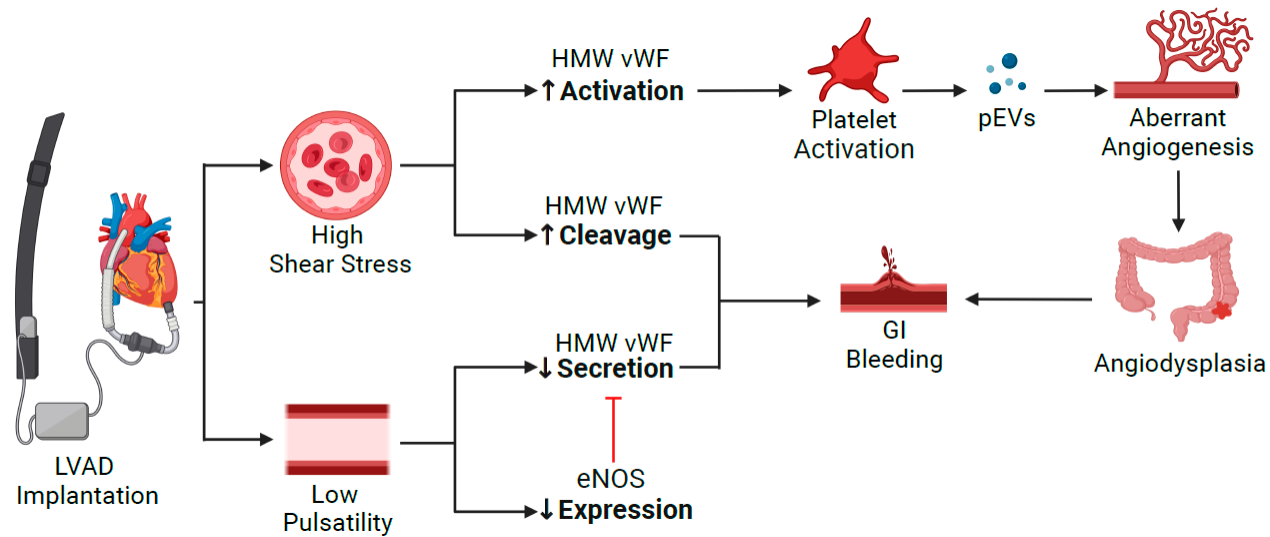
Figure 2. Pathophysiology of GIB in patients supported with CF-LVAD. VWF deficiency is the common pathway for development of angiodysplasia due to the high shear stress and continuous flow. eNOS: endothelial nitric oxide synthase; GI: gastrointestinal; HMW VWF: high molecular weight von Willebrand Factor; pEVs: platelet-derived extracellular vesicles.